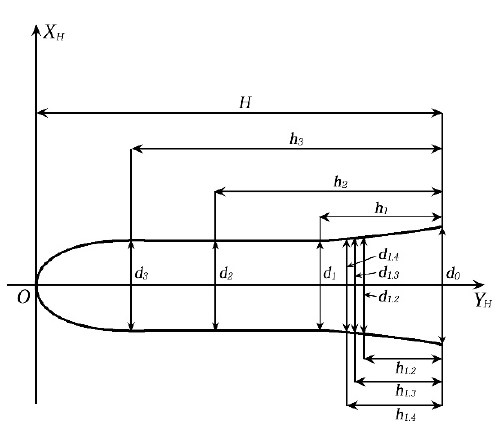
Figure 10. Schematic diagram of the tree height calculated by the Kunze M. stem curve equation.